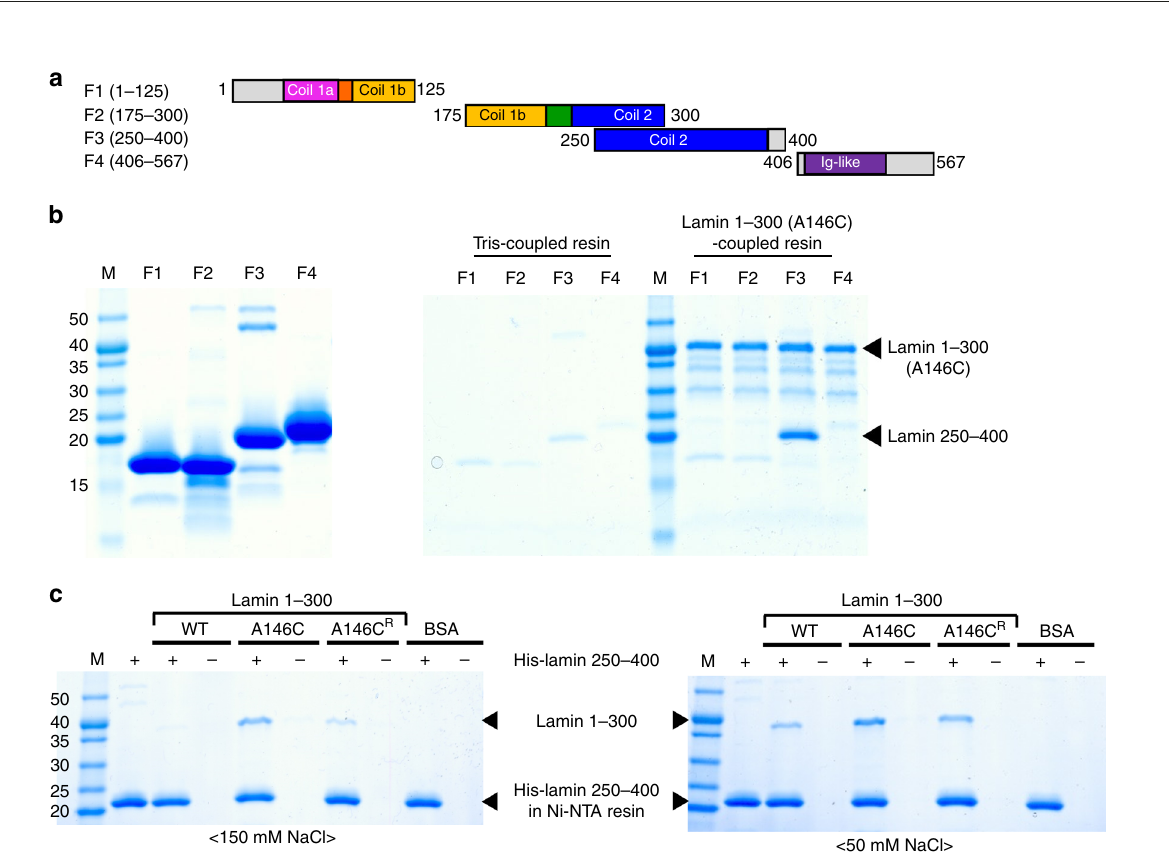
Fig. 3 A11 interaction of the lamin 300 fragment. a Structural comparison of the tetrameric structures of the lamin 300 fragment (this study, residues 75 – 213) and vimentin coil 1b (PDB code: 3UF1 18 , residues 144 – 251). Top panel, the anti-parallel contact region and its three compartments (left side, central part, and right side) of the lamin 300 fragment are indicated by double-headed arrows. Four chains (chains A – D) are in green, blue, violet, and yellow, respectively. Left and right-side parts of the lamin 300 fragment and vimentin are marked as dotted boxes. The N and C terminus of each chain is indicated by N and C, respectively. The contact interfaces between chain A:B and C:D are marked as black boxes labelled with a – e, which are enlarged in b . b Residues involved in hydrophobic or molecular contacts are shown in the stick representations. See also Supplemental Fig. 4 for interfaces of the vimentin. c SEC pro fi le of the lamin 300 fragment A146C mutant and molar ratio of disul fi de-bonded proteins in each peak on Superdex 200 10/300 column. Five labelled fractions (left) were analysed using non-reducing SDS-PAGE (middle), and the relative portion of disul fi de-bonded protein (tetramer) to free Cys protein (dimer) was calculated based on the band intensity using ImageJ (right). d SEC-MALS analysis of lamin 300 fragment (2.5 mg/ml, wild type; left and A146C mutant; middle) in the absence (black line) or presence of a reducing agent TCEP (red line). Relative refractive index (right y -axis) and molecular weight of each peak (left y -axis) are plotted against the elution volume. The protein samples were also analysed using SDS-PAGE in the presence or absence of the reducing agent TCEP (right). Molecular sizes (kDa) of the marker proteins (M) are labelled on the left. Note that MALS might not give the accurate values when two peaks were not resolved. Considering the SDS-PAGE analysis of the fractions (in c ), the two peaks (middle) correspond to the tetramer and dimer, respectively